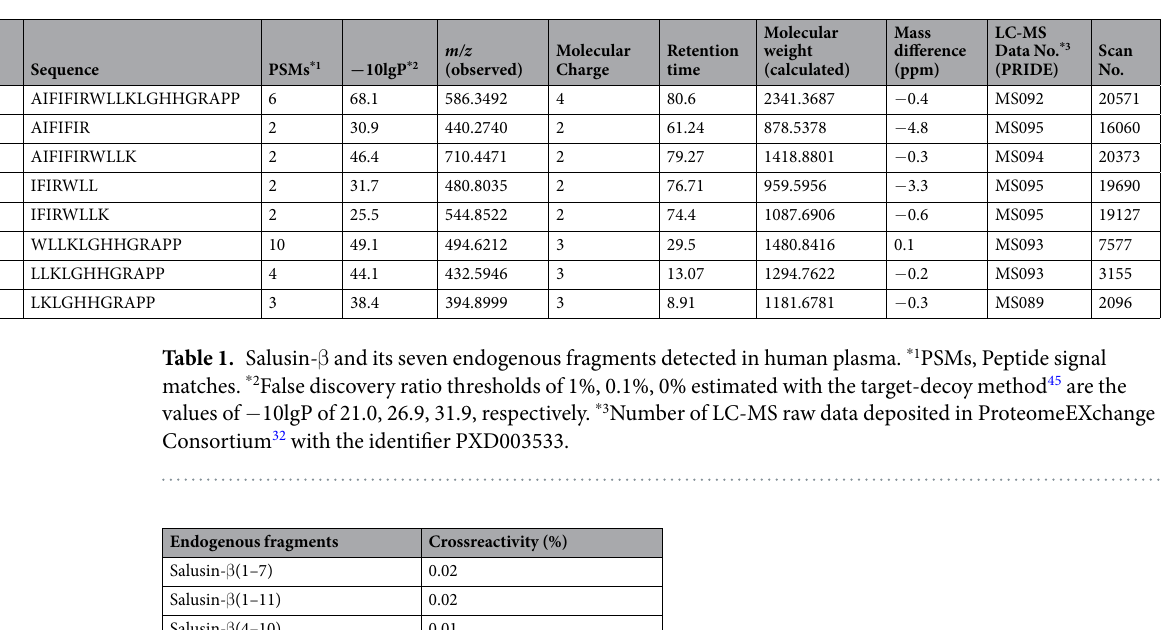
Figure 2. Plasma salusin- β concentrations in healthy volunteers. ( a ) Apparent parallelism between salusin- β standard and human plasma samples by sandwich ELISA. Serially diluted synthesized salusin- β reconstituted and diluted with 0.025% NP40/PBS to concentrations of 2.3–46.8 ng/mL (1.0–20 nmol/L, closed circles) was compared with serially diluted human plasma samples (1:5–1:20, open circles). ( b ) Night-time fluctuations of plasma free salusin- β levels measured in 5 healthy volunteers under ambulatory conditions between 8 pm through to 9 am the next morning, compared against physiological autonomic functions determined by heart rate variability measurements. Closed squares and closed triangles with dotted lines represent changes of parasympathetic nervous function as assessed by high frequency components (HF) and the root mean square of successive differences of normal-to-normal intervals (RMSSD). Each closed point with horizontal bars indicate the mean ± SE levels. * P < 0.05 compared against 9 am samples. ( c ) Effects on plasma salusin- β after Valsalva maneuver. Seven healthy subjects (3 males and 4 females) were given Valsalva maneuver, and plasma salusin- β levels were measured before and 15, 30, 45 and 60 s after the start of the maneuver. * P = 0.0078 compared against baseline values.